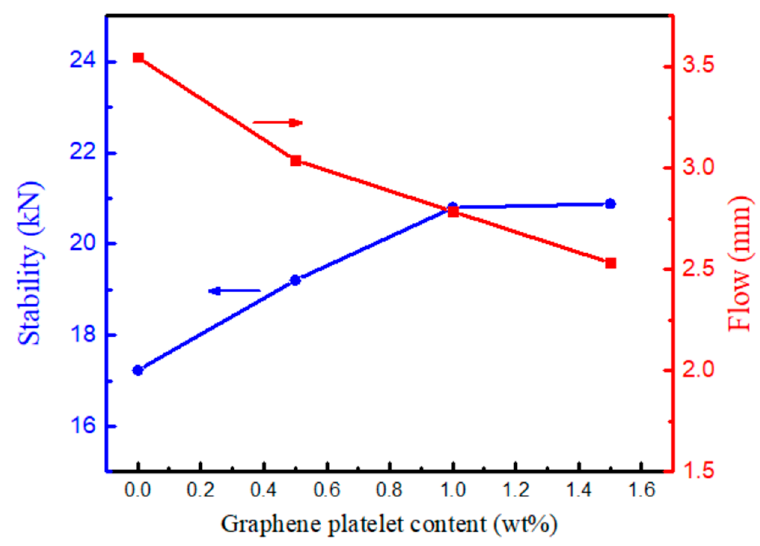
Figure 10. Marshall stability and flow resistance depth of asphalt mixes containing GnPs.